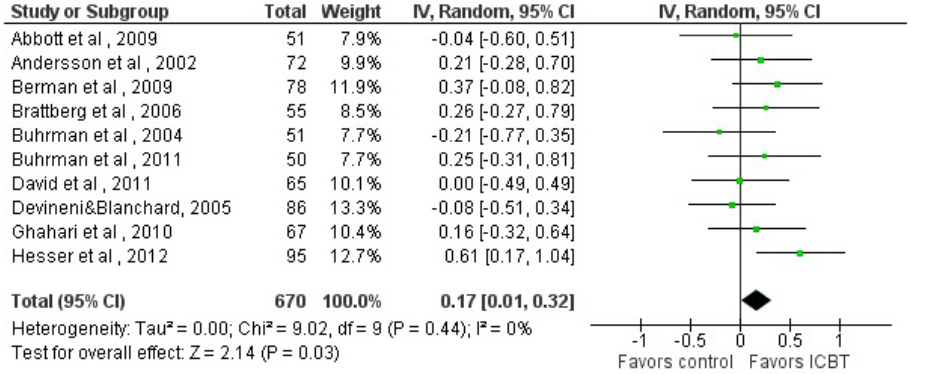
Figure 5. Forest plot of standardized mean differences of the effect on anxiety of Internet-based cognitive behavioral therapy compared with a passive control